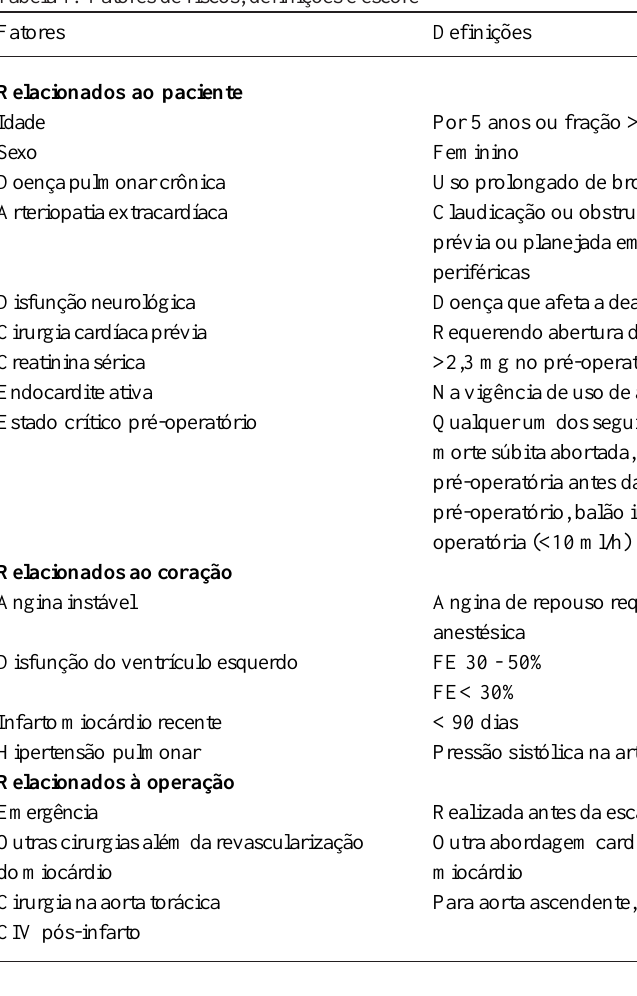
Tabela 1. Fatores de riscos, definições e